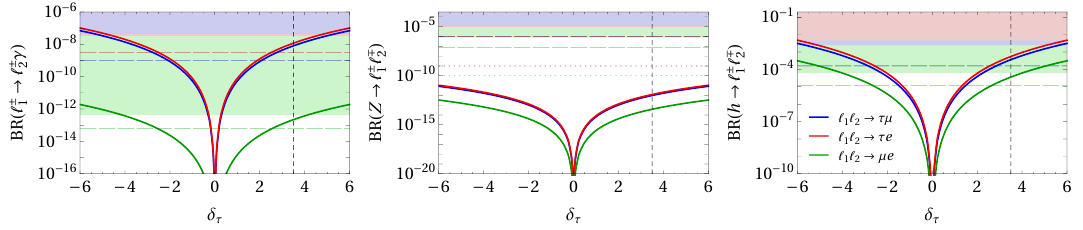
Figure 3 . The branching ratios as functions of the Yukawa couplings δ τ = δ µ = δ e . See the caption of figure 2 for further